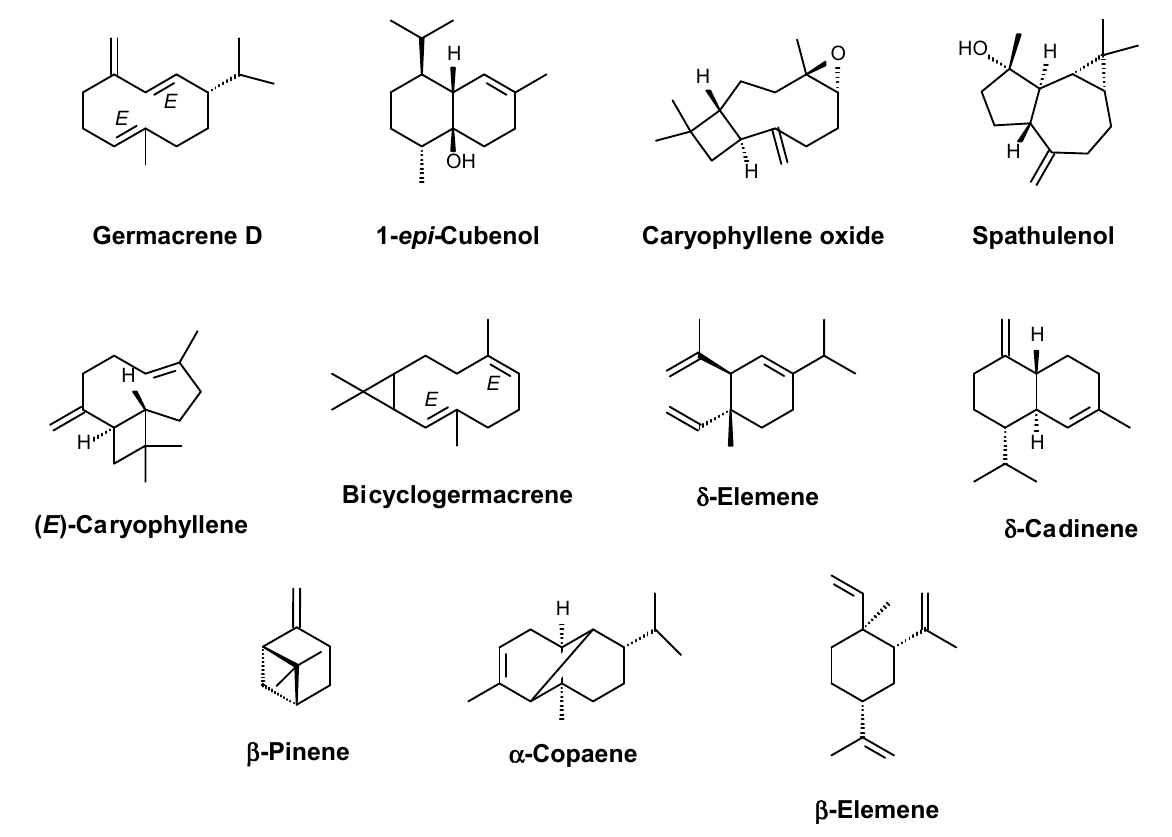
Figure 1. Main compounds identified in G. olivacea leaf EO.